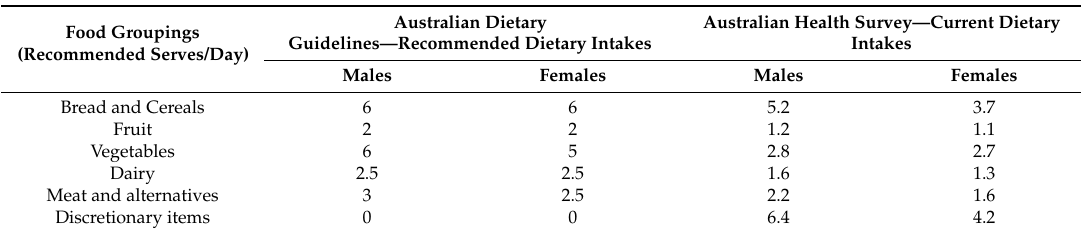
Table 1. Comparison of the recommended and current Australian diets for males and females (19–50 years) [12]. Australian Dietary Guidelines—Recommended Dietary